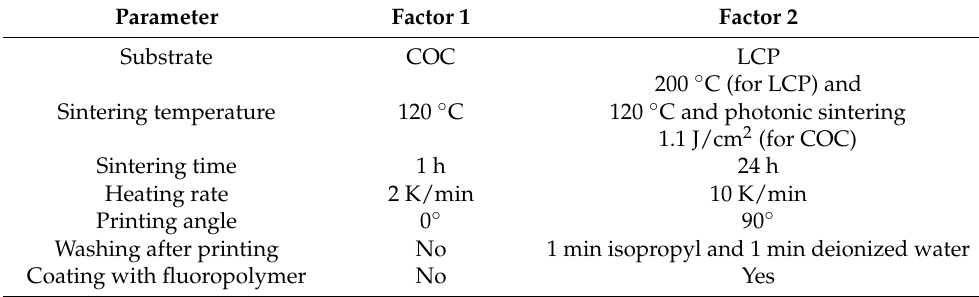
Table 2. The DOE with seven parameters and two factors. Those parameters were investigated in a Taguchi screening design of experiment.